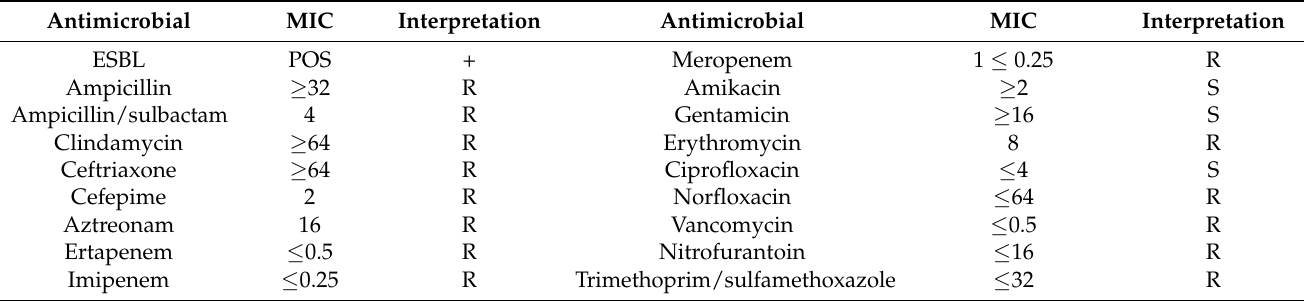
Table 6. VITEK 2 system for the identification and susceptibility testing of Acinetobacter baumannii .